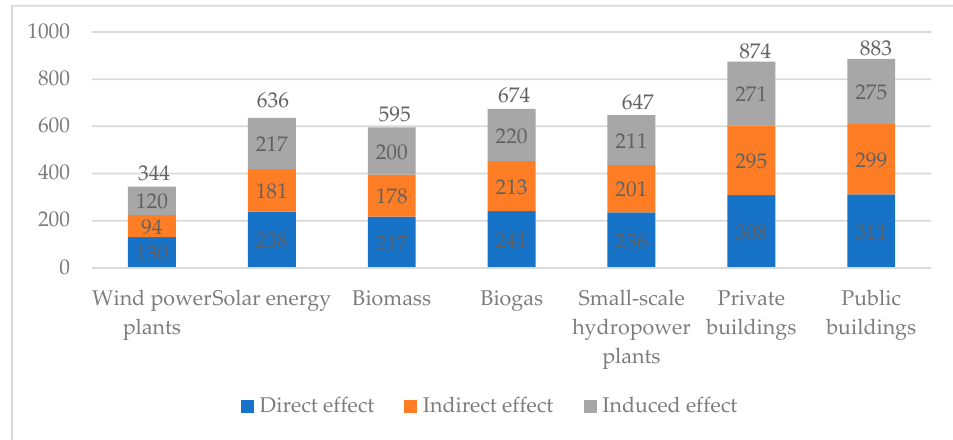
Figure 1. GVA effects induced by EUR 1 million, effects in thousands EUR. Source: authors’ calcu- lation.